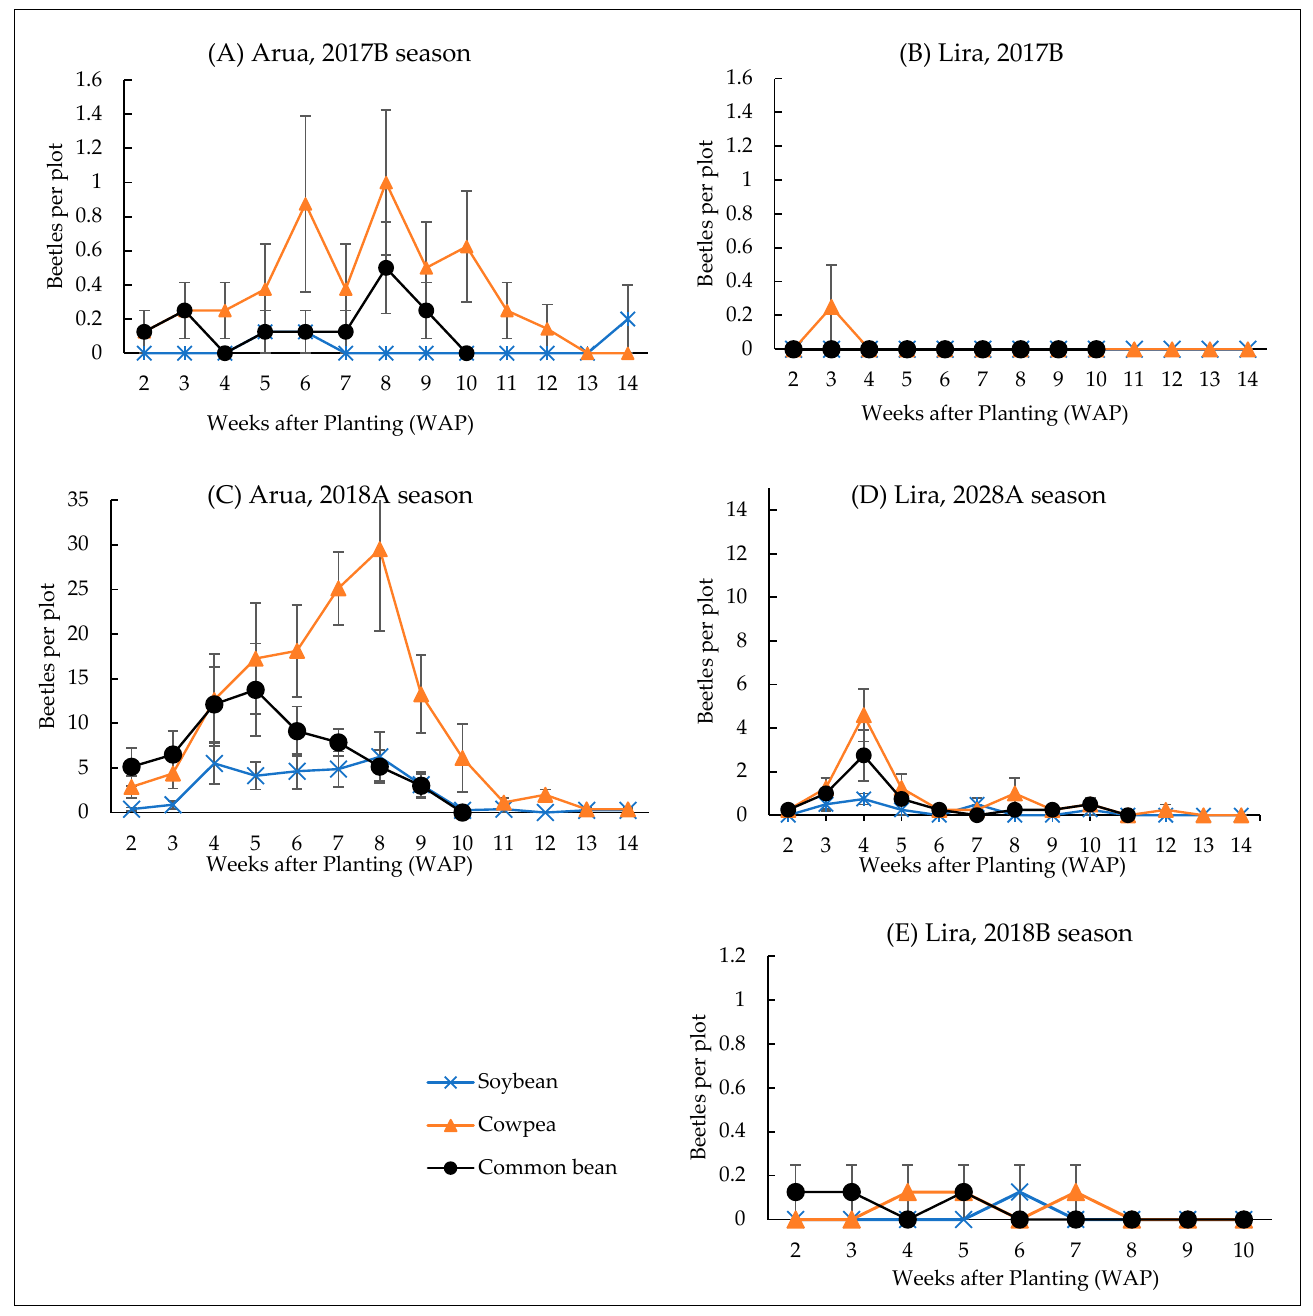
Figure 2. Abundance of adult Ootheca spp. on common bean, cowpea, and soybean in Arua and Lira district during the short rain season in 2017 ( A , B ), long rain ( C , D ) and short rain ( E ) seasons in 2018. The common bean growth stages of seedling, vegetative with branching, flowering and pod formation, and pod maturation correspond for two to three, four to five, six to eight, and nine to eleven weeks after planting, respectively. There is no graph for Arua, 2018B season because no beetles were recorded at the location during that